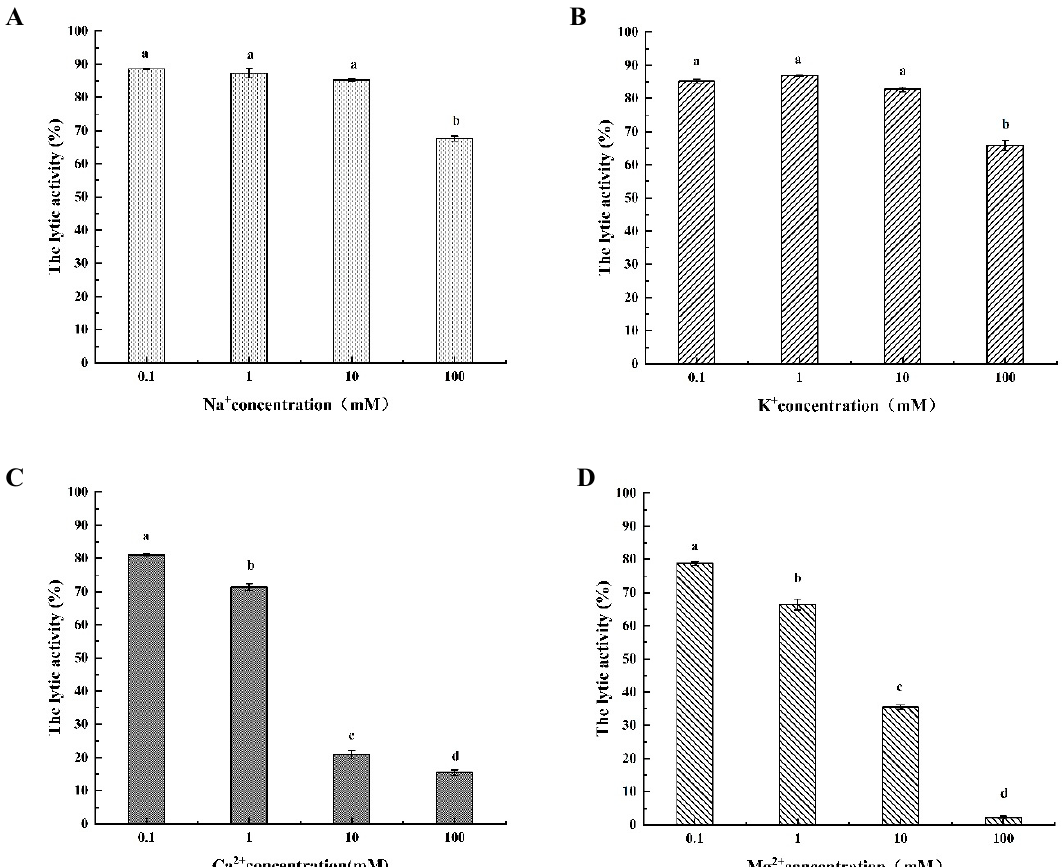
Figure 5. The different metal ionic effects of LysSE24 activity. A . Effect of sodium ion on the lytic activity of endolysin LysSE24. B . Effect of potassium ion on the Lysis of Endolysin LysSE24. C . Effect of calcium ion on lytic activity of endolysin LysSE24. D . Effect of magnesium ion on the cleavage of endolysin LysSE24. Calculate the lytic activity by using the formula: 100% × (OD 600 nm of control − OD 600 nm of the reaction mixture with endolysins) / the initial OD 600 nm of the control. The different letters (a, b, c, and d) in the figure indicate significant differences ( p < 0.05).